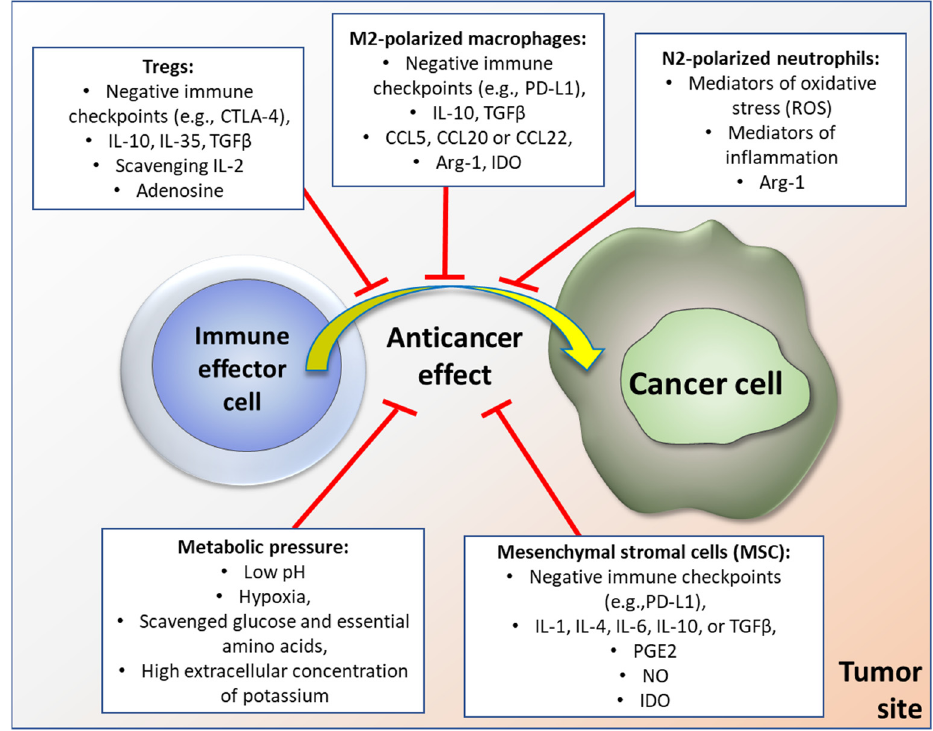
Figure 1. Examples of factors within tumor microenvironment that inhibit anticancer immune response (please see text for details).